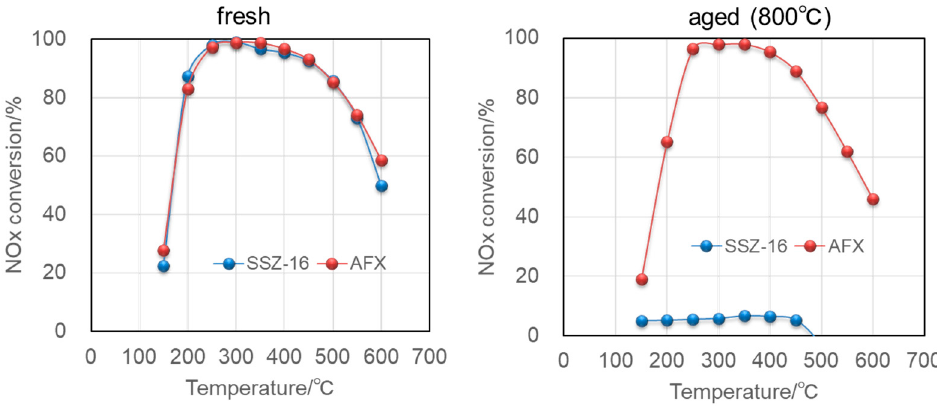
Figure 3. Catalytic performances for NH 3 -SCR on fresh and hydrothermally-aged AFX (red) and SSZ-16 (blue).